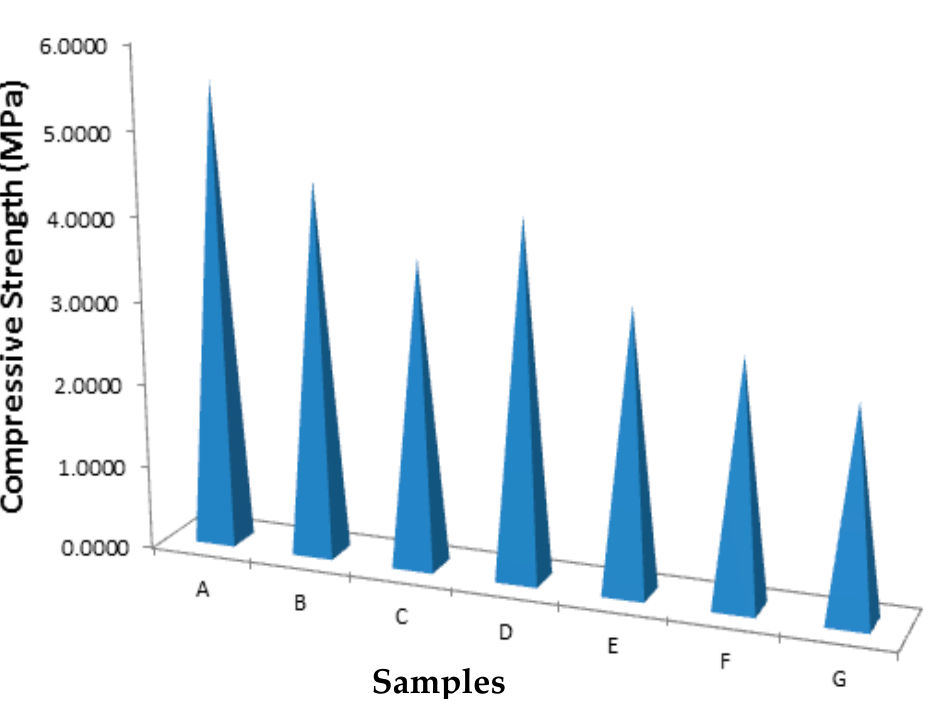
Figure 7. Compressive strength of the samples.